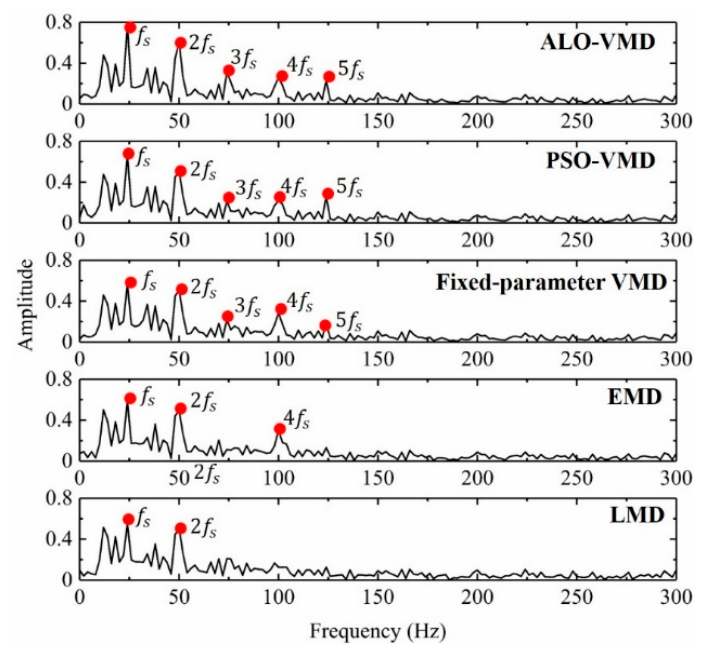
Figure 21. The envelope spectrum of five decomposition methods for the experimental signal.